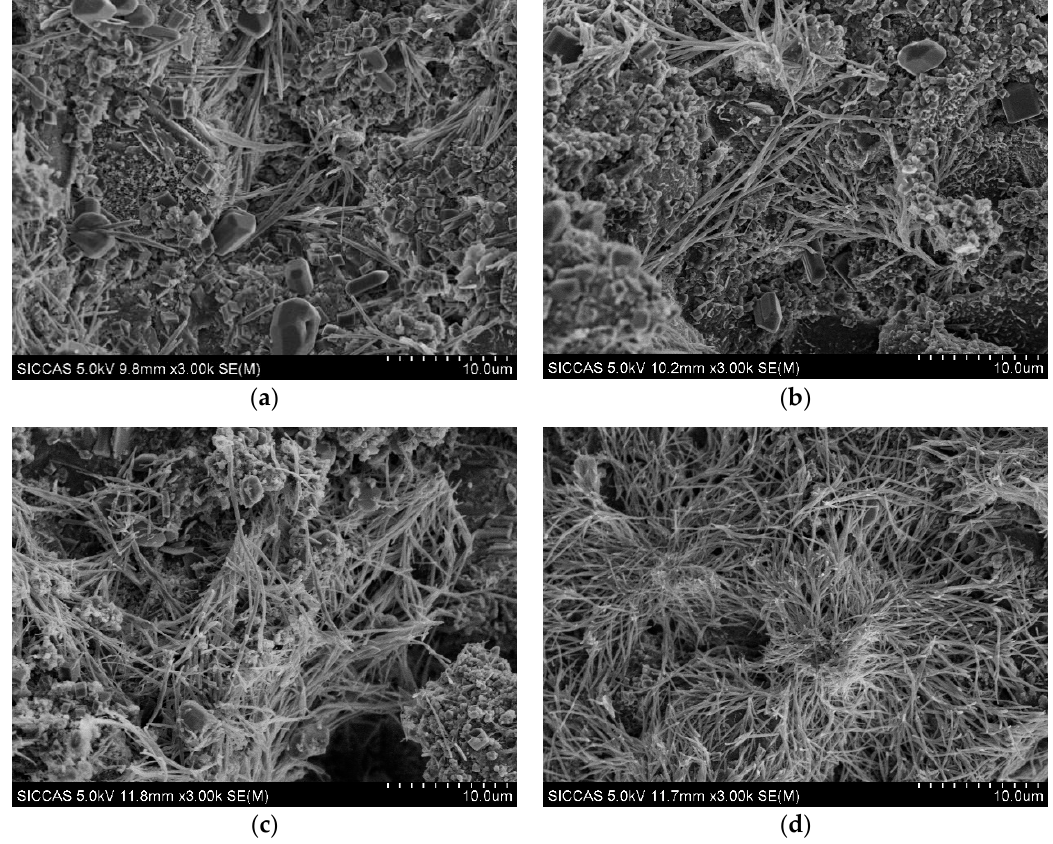
Figure 13. SEM image of the cement mortar hydration products after 24 h hydration: ( a ) control, ( b ) 0.03%, ( c ) 0.05%, and ( d ) 0.5%.